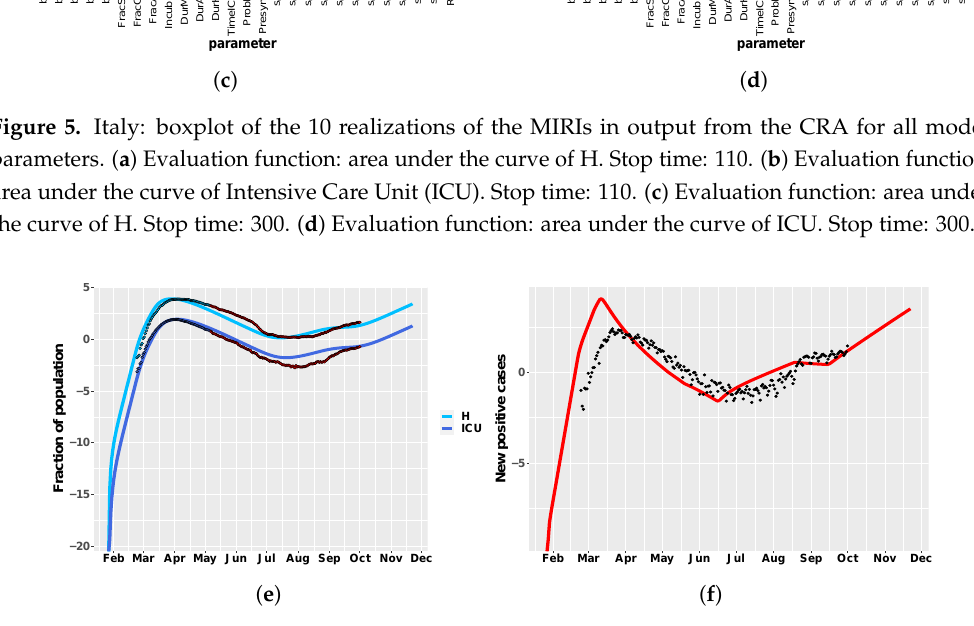
Figure 6. Italy. ( a ) time behavior of hospitalized (light blue) and ICU (blue) patient in comparison with data of the Italian Civil Protection Department [21]. Data in red represent the second portion of the available dataset, from 4 May until 1 October 2020, which were not employed in model calibration. The newly introduced intervention parameters are set to: s 05 = 0.11, s 06 = 0.13, s 07 = 0.27, s 08 = 0.22, s 09 = 0.3. ( b ) Italy: time evolution of new positive cases in comparison with the data in